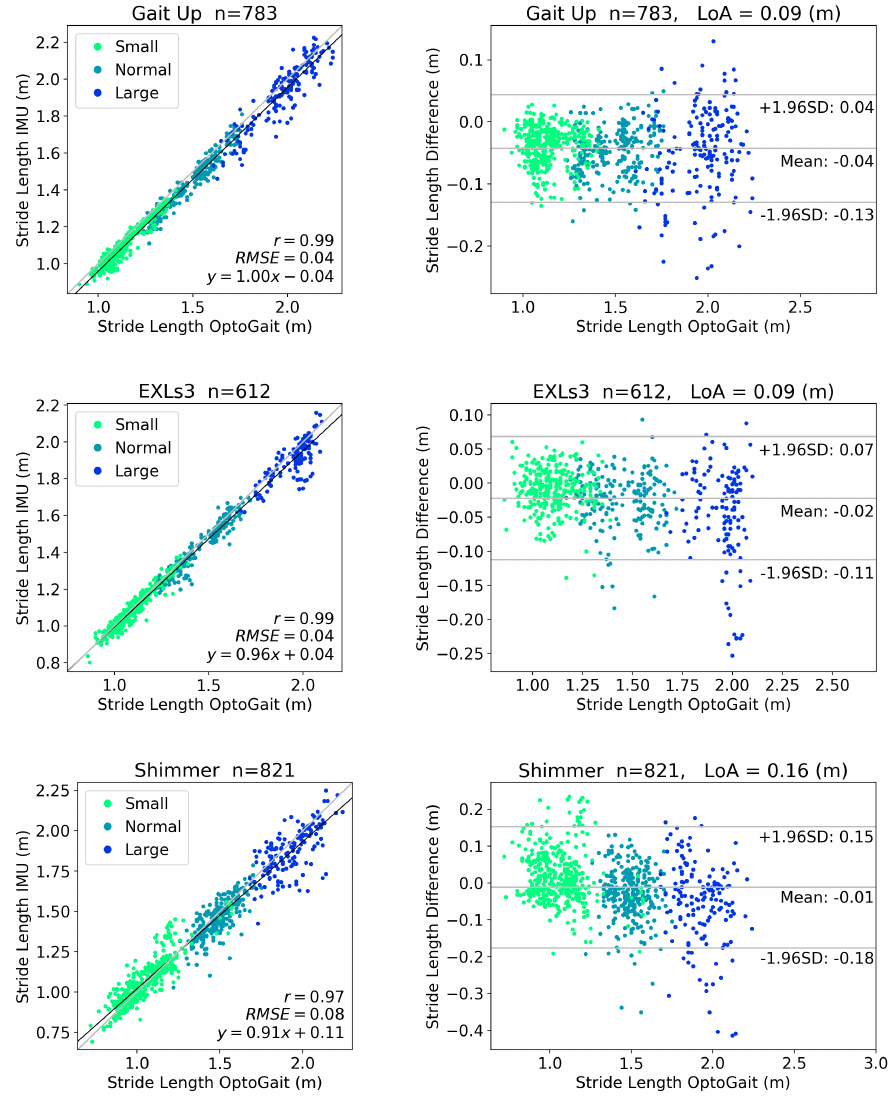
Figure A4. Correlation analysis and Bland–Altman plots of stride lengths from IMU and OptoGait. r: correlation coefficient, RMSE: root mean square error, LoA: average limits of agreement at ± 1.96 standard